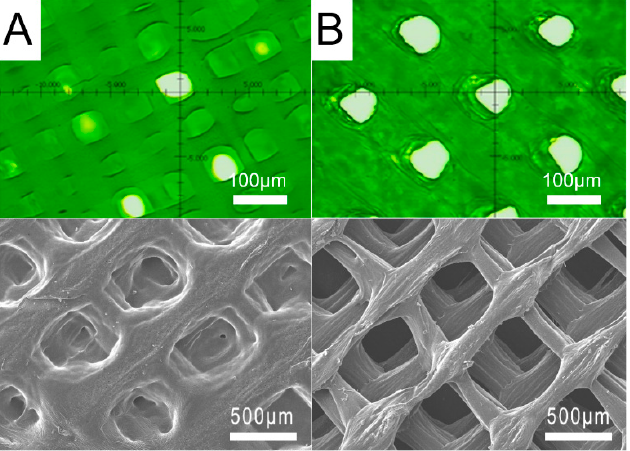
Figure 9. Profile projector and FESEM images of parts manufactured with PCL/DCM ratios of ( A ) 5 g/7.2 mL, ( B ) 5 g/6.8 mL.